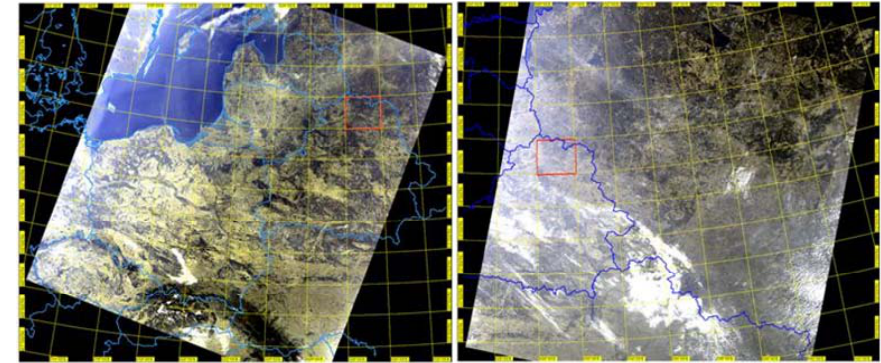
Fig. 10. Composite RGB images: MERIS on ENVISAT platform; 11 October 2005 (left) and 1 May 2006 (right).